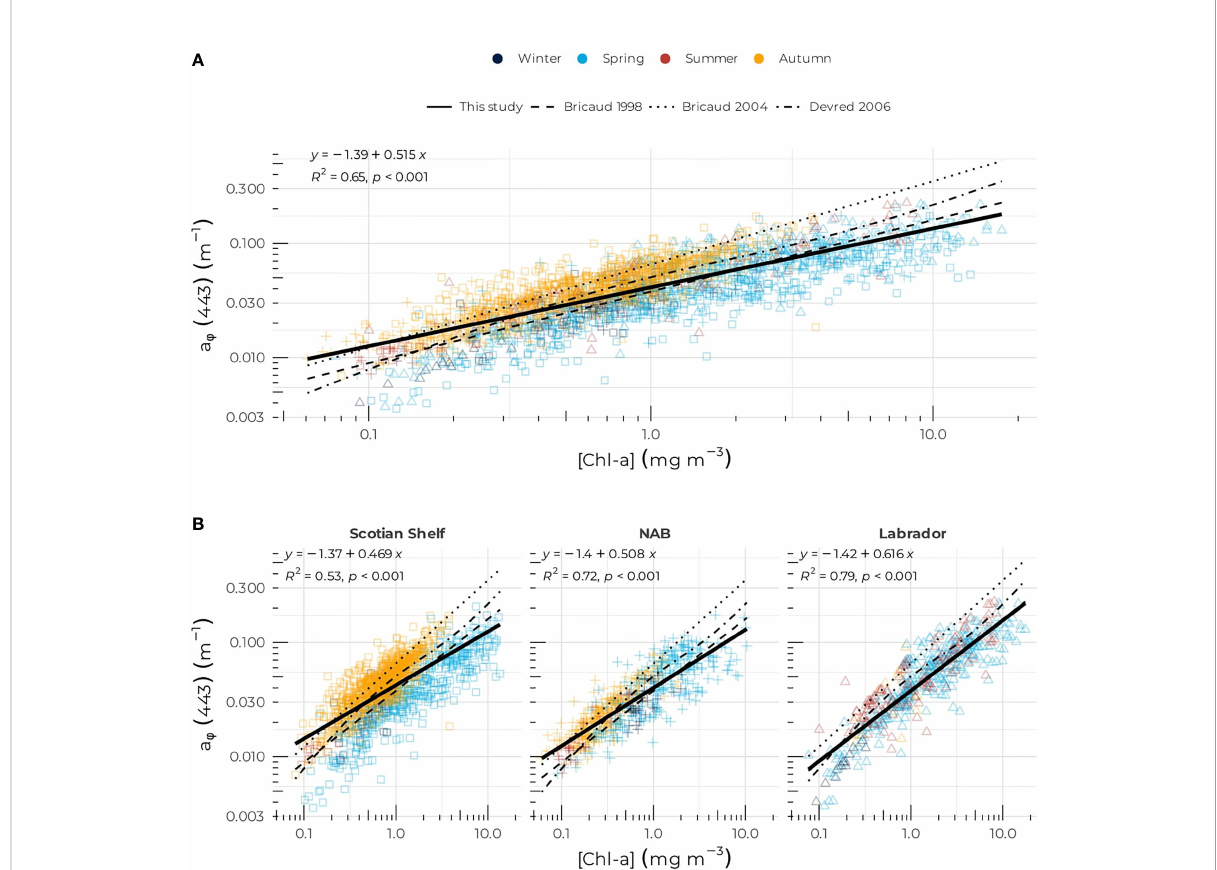
FIGURE 4 Phytoplankton absorption coef fi cient at 443 nm, a f (443), as a function of [Chl-a] for (A) the entire dataset, (B) the Scotian Shelf (left panel), the Northwest Atlantic Basin (rmiddle panel), and the Labrador Sea (right panel). The solid black lines correspond to the power law fi t (Equation 3); the long-dashed, short-dashed, and dotted-dashed lines correspond to Broca ’ s et al. (1998), Bricaud (2004), and Devred et al. (2006), models respectively. Symbols are color-coded according to season as in Figure 2.